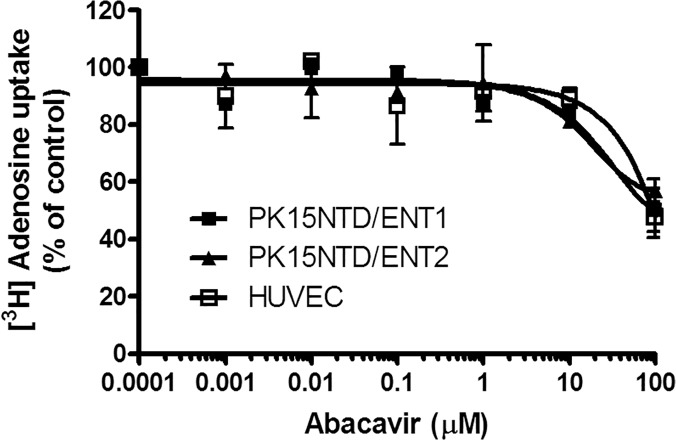
Effects of abacavir on adenosine uptake in HUVECs, PK15NTD/ENT1 cells and PK15NTD/ENT2 cells.[3H]adenosine uptake (10 μM, 2 μCi/mL) by HUVECs (□), PK15NTD/ENT1 cells (■) and PK15NTD/ENT2 cells (▲) was measured at room temperature for 4 min in the presence of abacavir (1 nM to 100 μM). Values are means ± S.E.M. of three experiments carried out in triplicate and statistical comparisons were made using ANOVA.